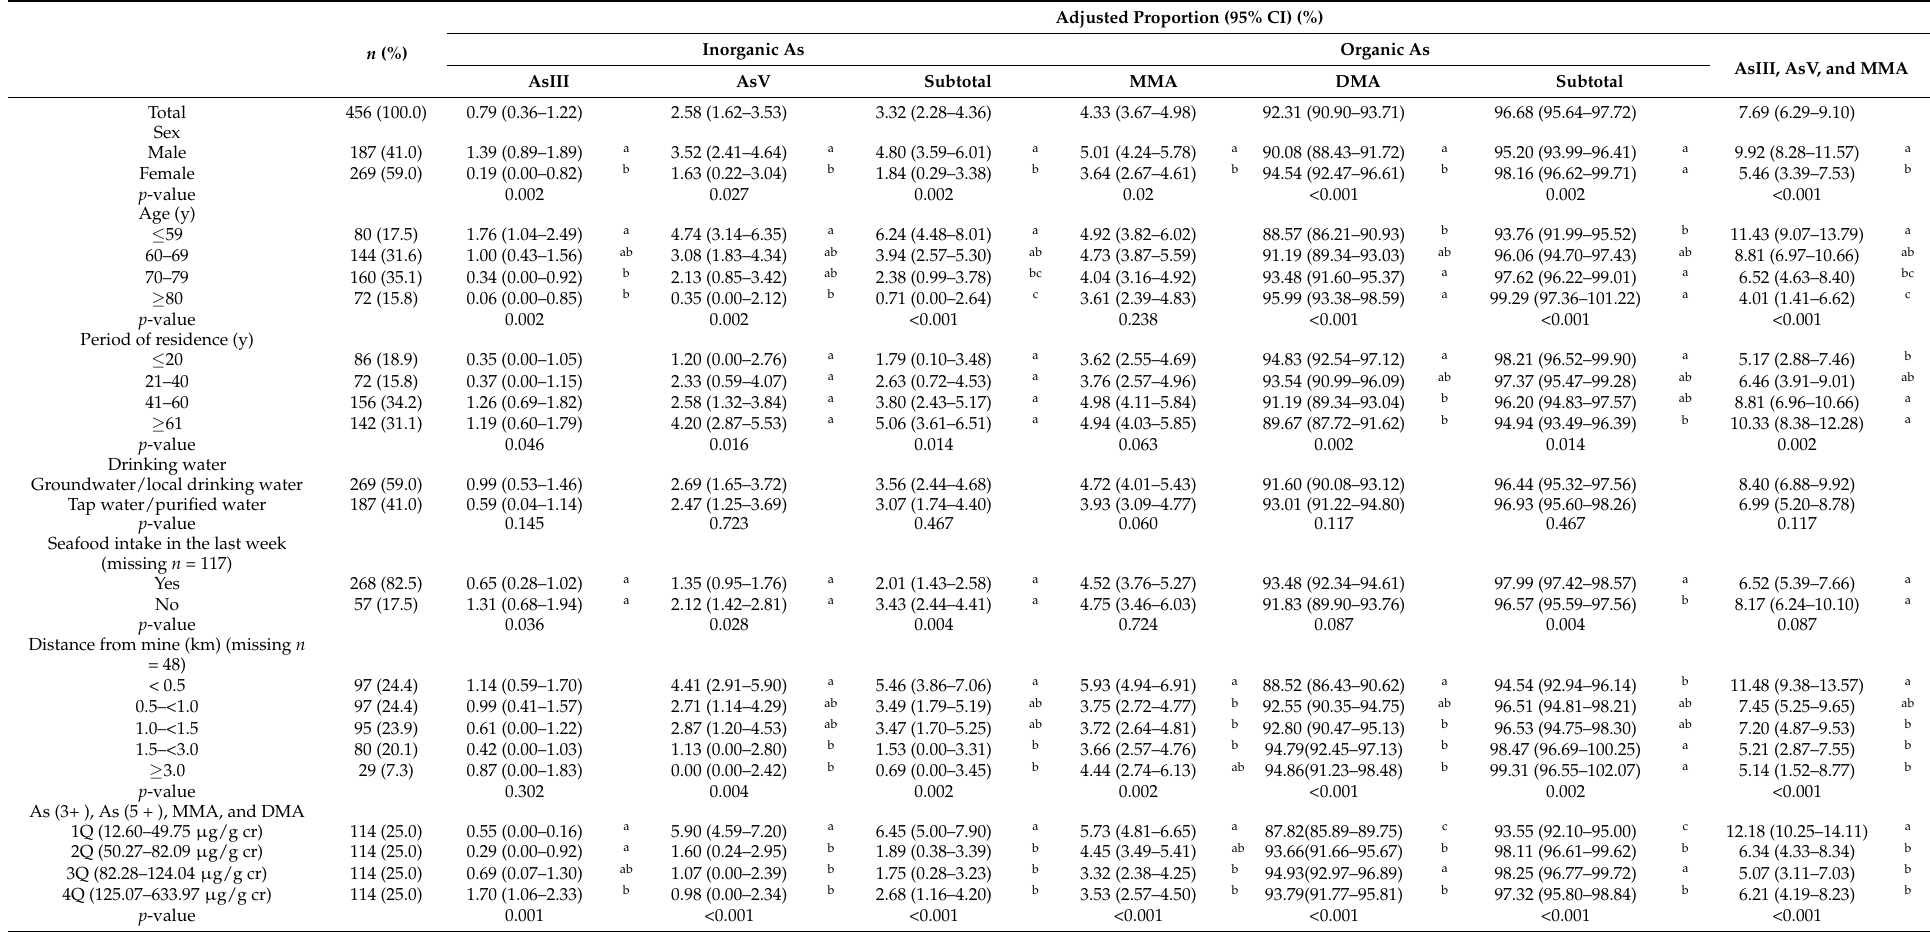
Table 2. Adjusted proportions of as species concentration relative to the sum of the concentrations of 4 As species in 103 abandoned metal